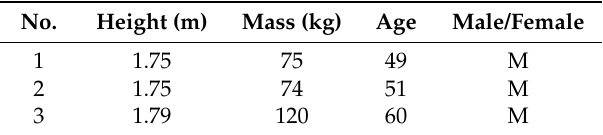
Table 2. Characteristics of individual researchers who worked in floodwaters at Gardens Point Road, Brisbane on 12 and 13 January